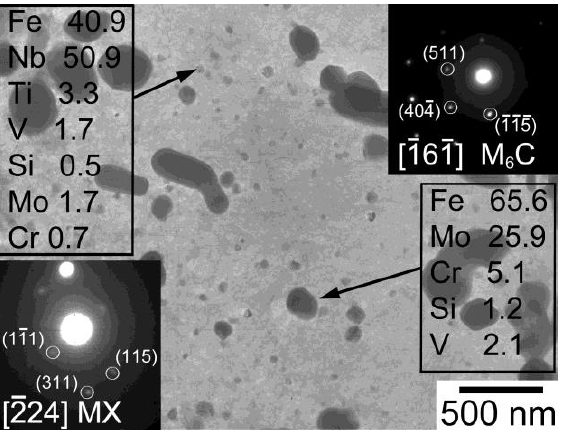
Figure 6. Typical precipitates in the thin foil of the 0.4%C-1.6%Si-1%Cr-0.95%Mo steel with V and Nb after quenching and tempering at 200 °C.